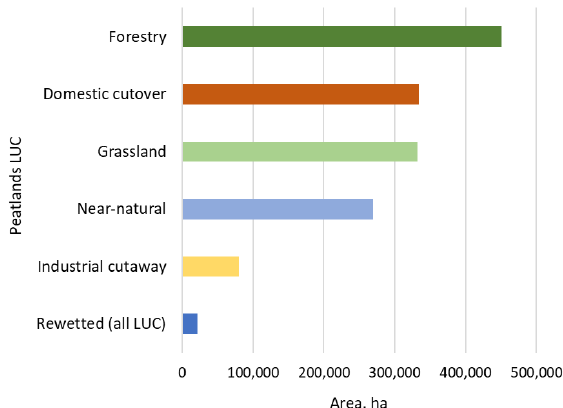
Figure 5. Proportion of peatlands in Ireland by land use category (LUC). Data sources: peatland areas for forestry, grassland and industrial peat extraction are taken from Duffy et al . (2021). The domestic cutover area is calculated as a subtraction from the total area of drained and near-natural Irish peatlands (Connolly & Holden 2009). The area of near-natural peatlands is taken from Wilson et al . (2013). The area of rewetted nutrient-rich peat extraction sites is provided by Bord na Móna. Rewetted forestry area is taken from Delaney & Murphy (2012). The area under rewetted nutrient-poor peat extraction is calculated as a substruction of rewetted areas mentioned above from the total area of rewetted peatlands (Wilson et al .